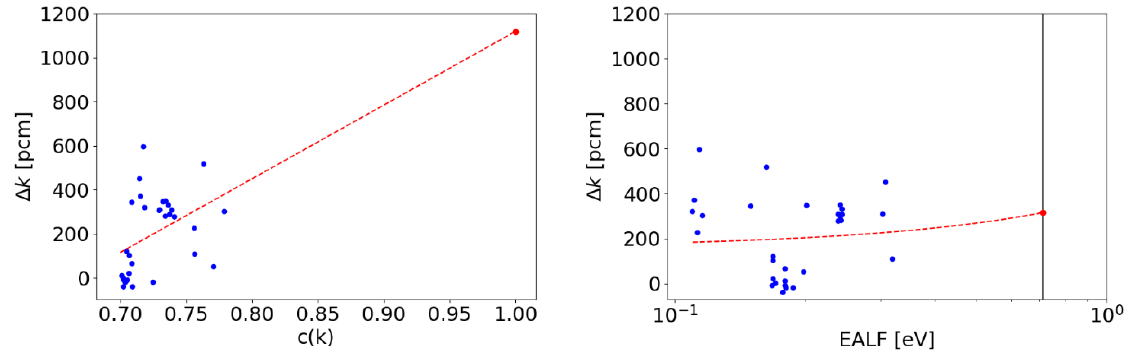
Figures 2e and 2f. The error between the model and the corresponding experiment as a function of c